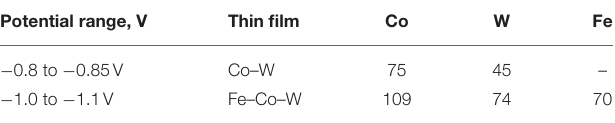
TABLE 2 | Tafel constants (mV/decade) at 23 ◦ C. Potential range, V